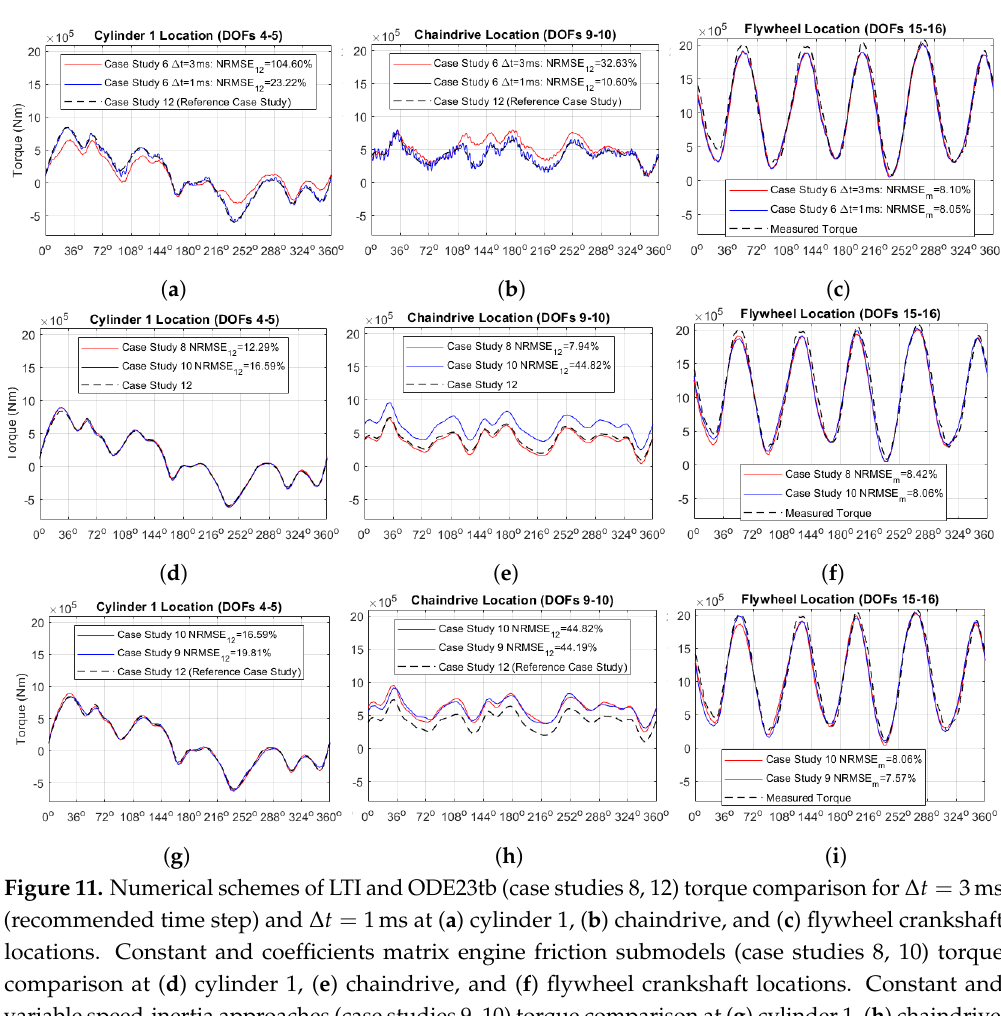
Figure 11. Numerical schemes of LTI and ODE23tb (case studies 8, 12) torque comparison for ∆ t = 3ms (recommended time step) and ∆ t = 1ms at ( a ) cylinder 1, ( b ) chaindrive, and ( c ) flywheel crankshaft locations. Constant and coefficients matrix engine friction submodels (case studies 8, 10) torque comparison at ( d ) cylinder 1, ( e ) chaindrive, and ( f ) flywheel crankshaft locations. Constant and variable speed-inertia approaches (case studies 9, 10) torque comparison at ( g ) cylinder 1, ( h ) chaindrive, and ( i ) flywheel crankshaft